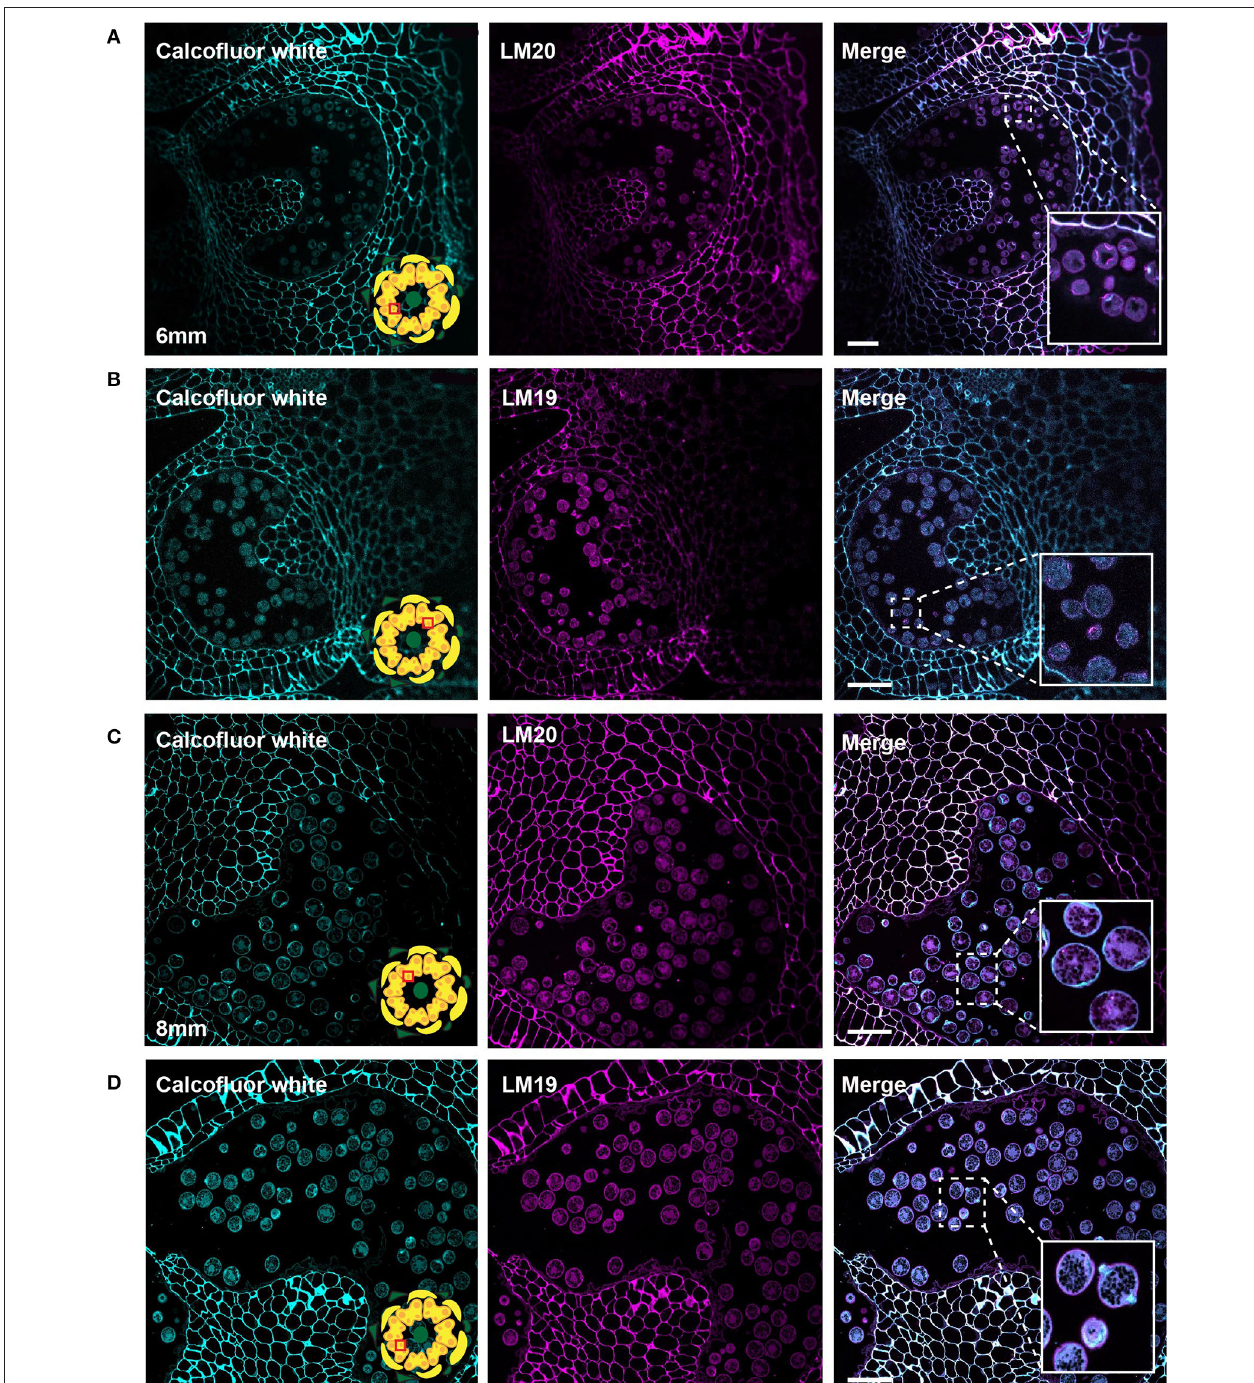
FIGURE 8 | LM20 and LM19 immunostaining of the 6-mm and 8-mm bud anthers. Fluorescent micrographs of anther cross sections (500nm) in LR white, of the 6-mm and 8-mm bud anther, stained with Calcofluor white and FITC conjugated anti-rat secondary for LM20 or LM19. Calcofluor white staining (cyan) (left). Aniline blue staining (magenta) (center). Merged staining (right). (A) LM20 staining of the 6-mm anther.The right panel inset, showing zoomed-in view of the pollen wall with the merged staining. (B) LM19 staining of the 6-mm anther. The right panel inset, showing zoomed-in view of the pollen with the merged staining. (C) LM20 staining of the 8-mm anther. The right panel inset, showing zoomed-in view of the pollen wall with the merged staining. (D) LM19 staining of the 8-mm anther. The right panel inset, showing zoomed-in view of the pollen wall with the merged staining. Scale bars 50 µ m.